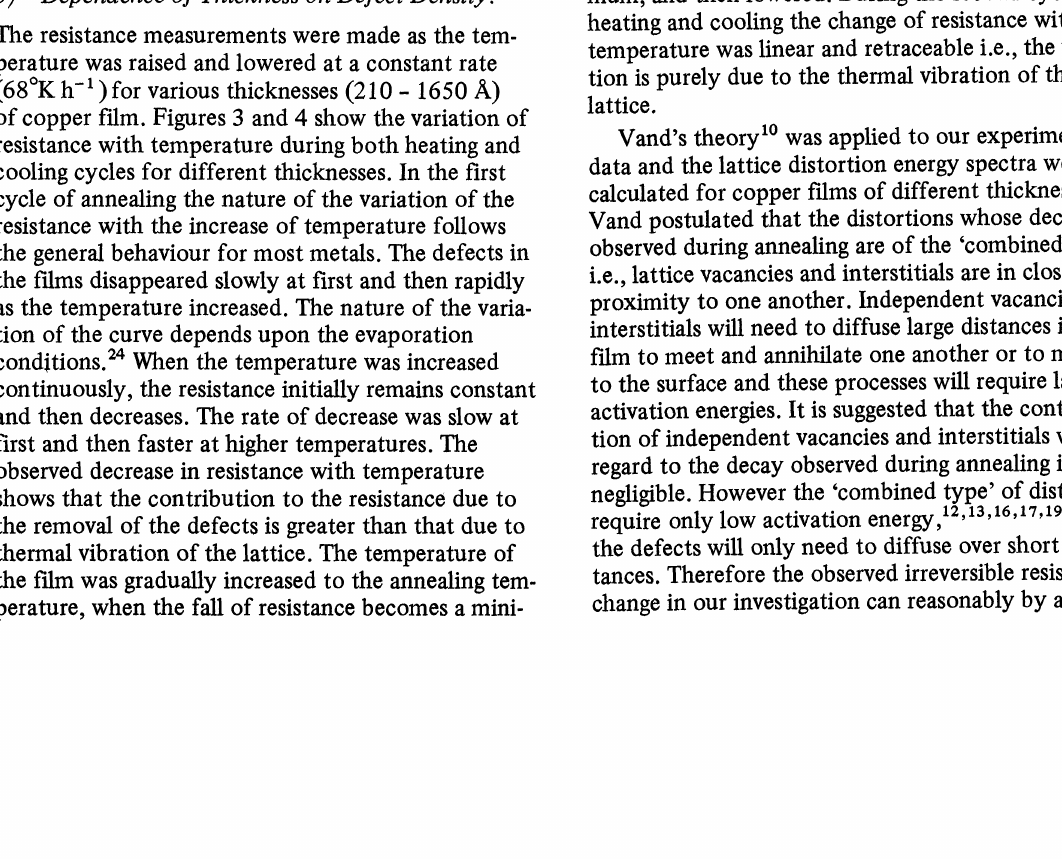
FIGURE 2 The variation of resistance with time for copper films of two different thicknesses (a) 210 A and (b) 430